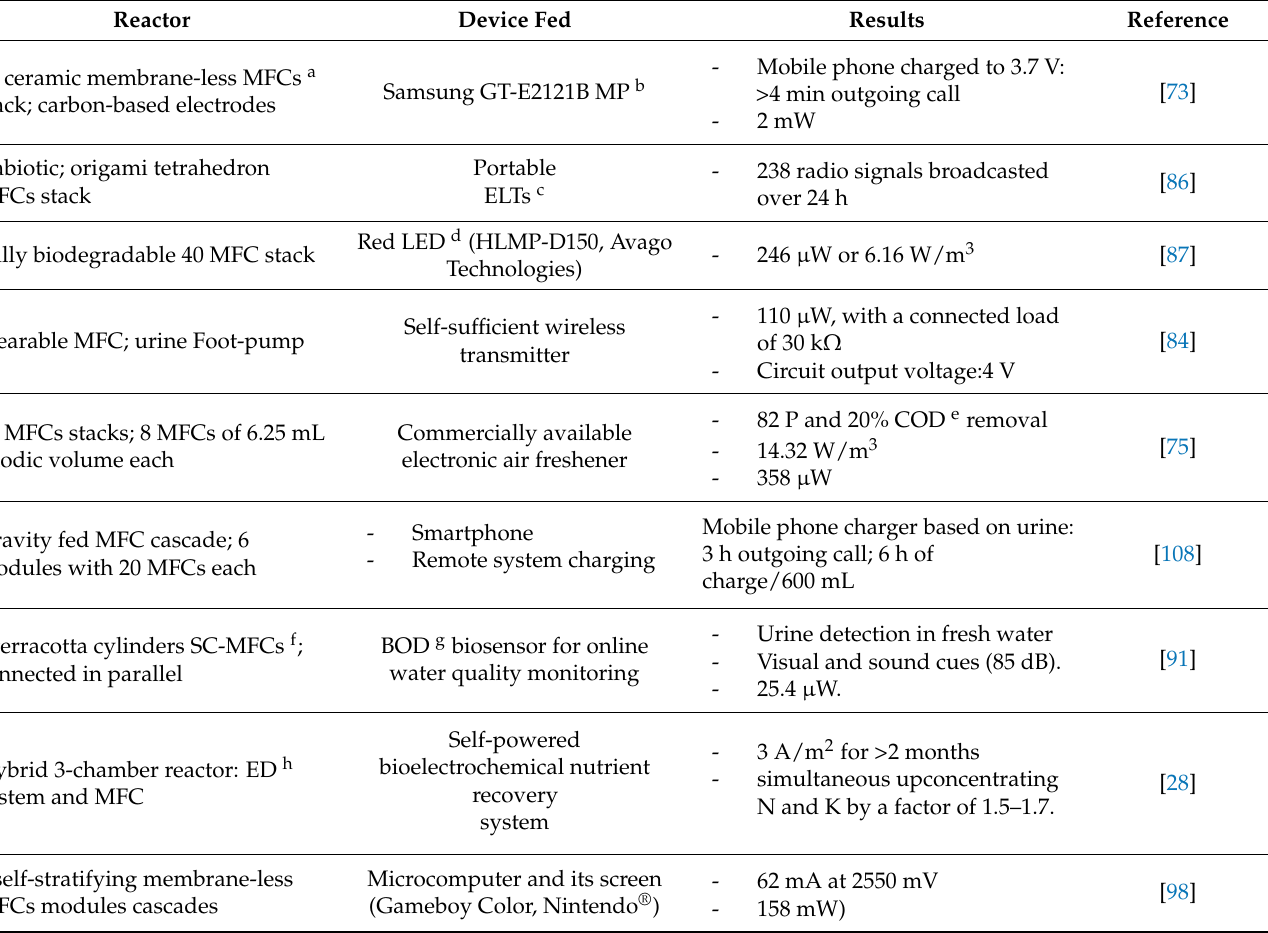
Table 5. Feeding on urine microbial fuel cells practical applications at laboratory